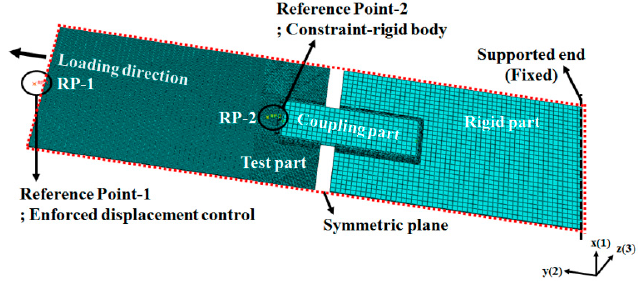
Figure 3. Finite element modeling for welded connection.